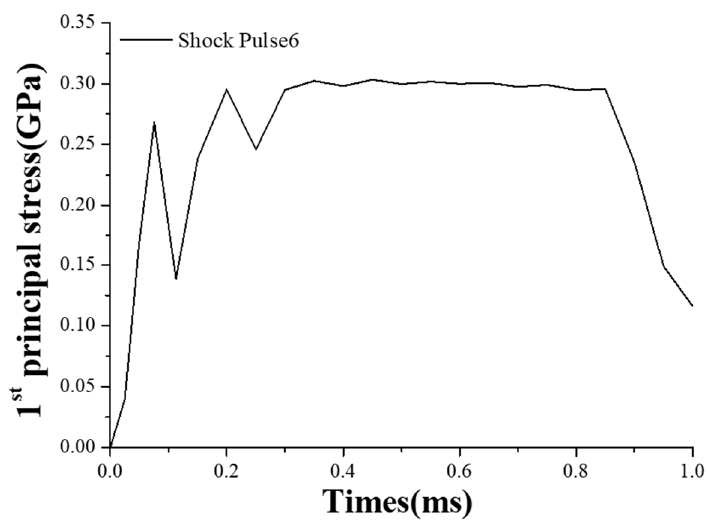
Figure 12. First principal stress of the MEMS tuning fork gyroscope under the impact of Shock Pulse 6 (a 0 = 25,000 g, τ = 1 ms).